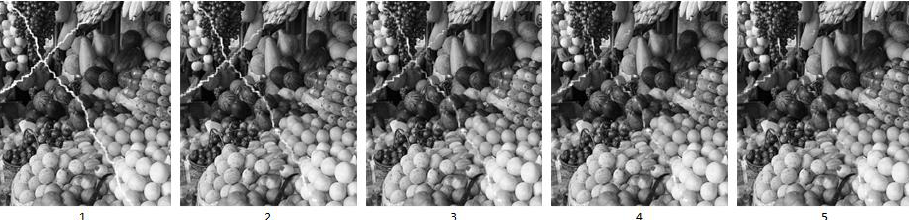
Fig. 4. The changes in the third test photo (fruits) as the truncated SVD iteration progressed.